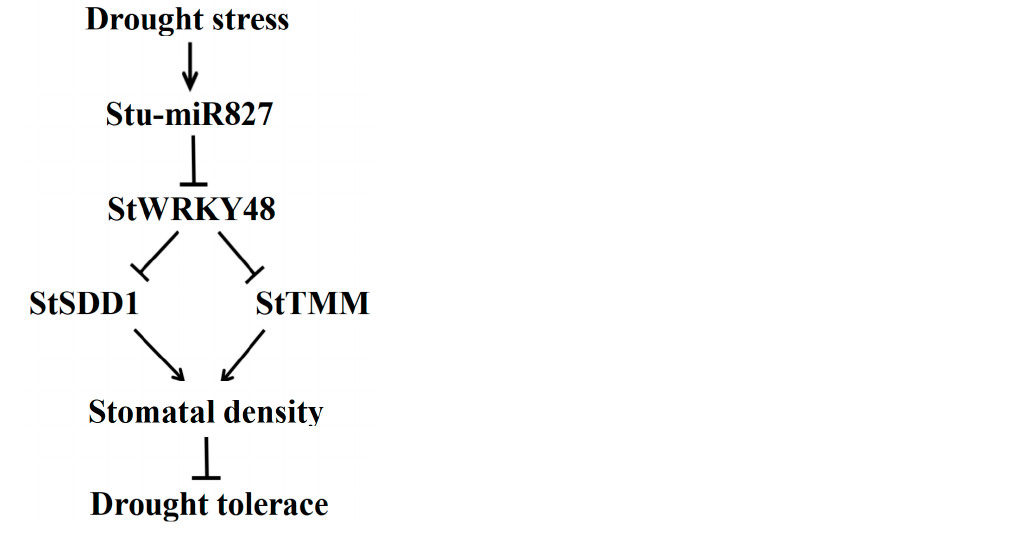
Figure 10. Schematic of stu-miR827 response in potato upon drought stress by regulating stomatal density.